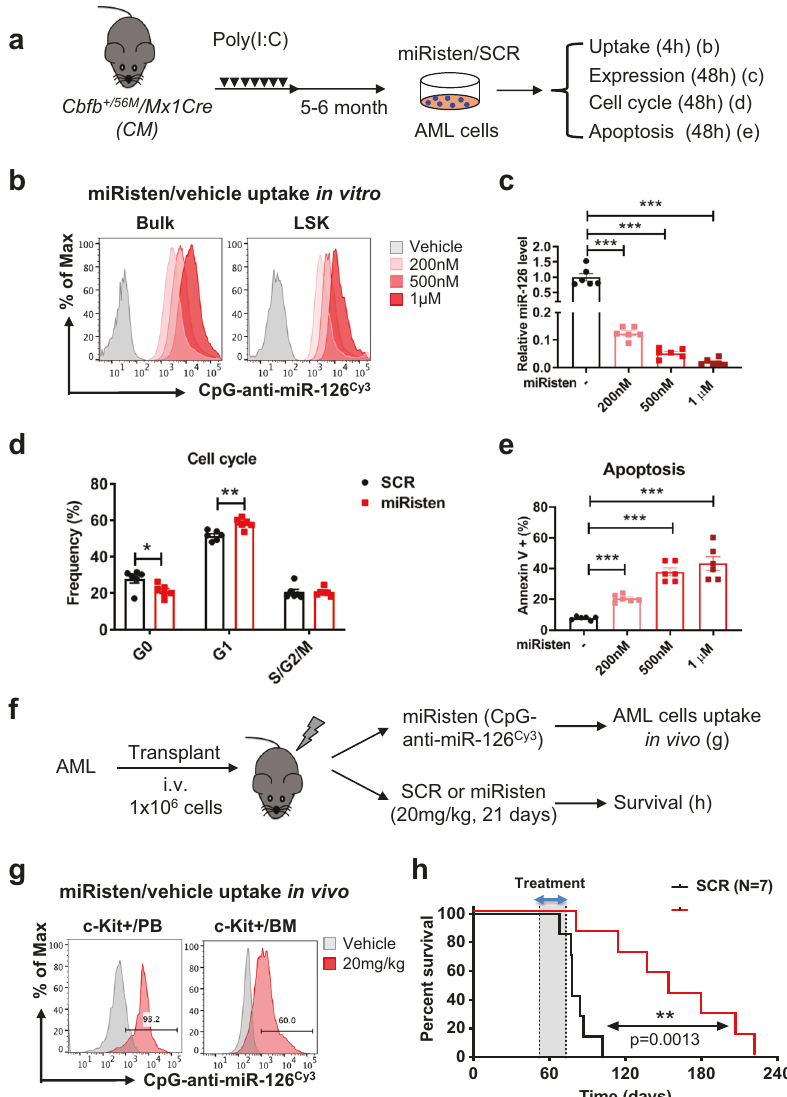
Fig. 6 Targeting miR-126 by miRisten increases AML cell apoptosis and delays CM-AML progression. a Schematic of experimental design. AML cells isolated from CM induced leukemia mice were treated with miRisten or SCR control ex vivo and assessed for uptake, miR-126 expression, cell cycle, and apoptosis at various time points. b The frequency of uptake for miRisten (CpG-anti-miR-126 cy3 ; red) or vehicle (gray) in bulk or LSK cells from CM leukemia BM. c Relative levels of miR-126 in CM AML cells after treatment with SCR control (black) or miRisten (200 nM, 500 nM, 1 μ M; pink/red; p < 0.0001 for all doses) as determined by qPCR and normalized to SnoRNA234 expression. d Frequency (%) of G 0 , G 1 , or S/G 2 /M phases of cell cycle in CM AML cells after treatment with SCR control (black) or miRisten (red; G 0 p = 0.031; G 1 p = 0.0017). e Frequency (%) of apoptotic cells de fi ned by Annexin V + in CM AML cells after SCR (black) or miRisten (pink/red; p < 0.0001 for all doses) treatment. f Schematic of treatment regimen. CM AML cells (1 × 10 6 cells/mouse) were transplanted into WT mice to generate a cohort of AML-bearing mice, which were randomly divided into two groups and treated with SCR control (20 mg/kg/dose, i.v., daily; n = 7) or miRisten (20 mg/kg/dose, i.v., daily; n = 7) for 21 days. g The frequency of uptake for miRisten (CpG-anti-miR-126 cy3 ; red) or vehicle (gray) in c-Kit + AML blasts in BM or PB 1 h after intravenous (i.v.) treatment with miRisten 20 mg/kg. h Kaplan – Meier survival curve of CM leukemic mice treated with SCR control (black line; n = 7; median survival 78 days) or miRisten (red line; n = 7; median survival 154 days). Dotted line with gray shade indicates treatment window; statistical difference for survival curves was determined using Log-rank (Mantel – Cox) test ( p = 0.0013). Each dot in c , d , e represents result from an individual mouse and data are presented as the mean ± SEM; statistics were calculated using two-tailed Student ’ s T tests (* p < 0.05; ** p < 0.01; *** p <